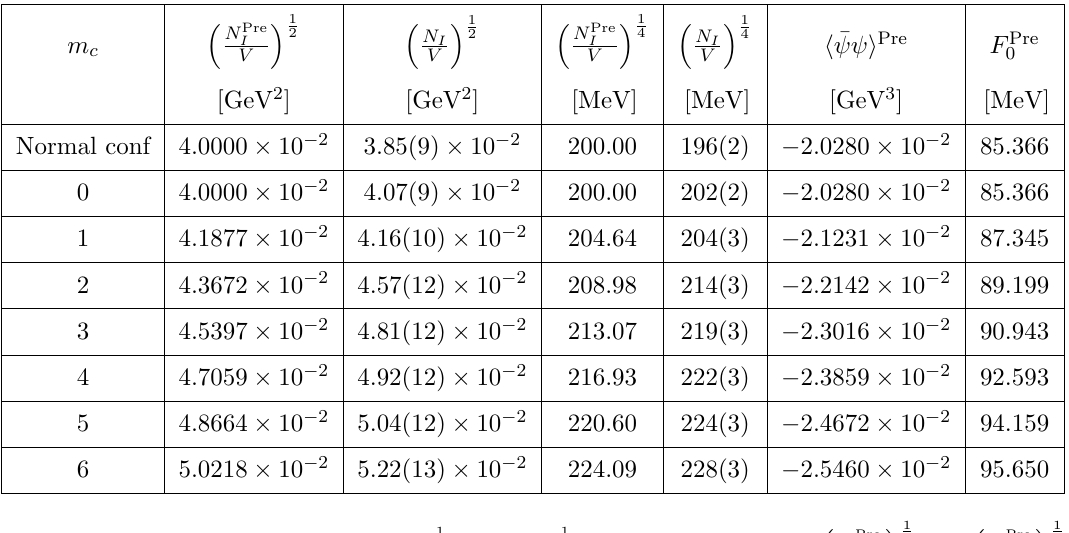
(cid:0) N (cid:1) 1 (cid:0) N (cid:1) 1 2 and 4 , and their predictions I I V V